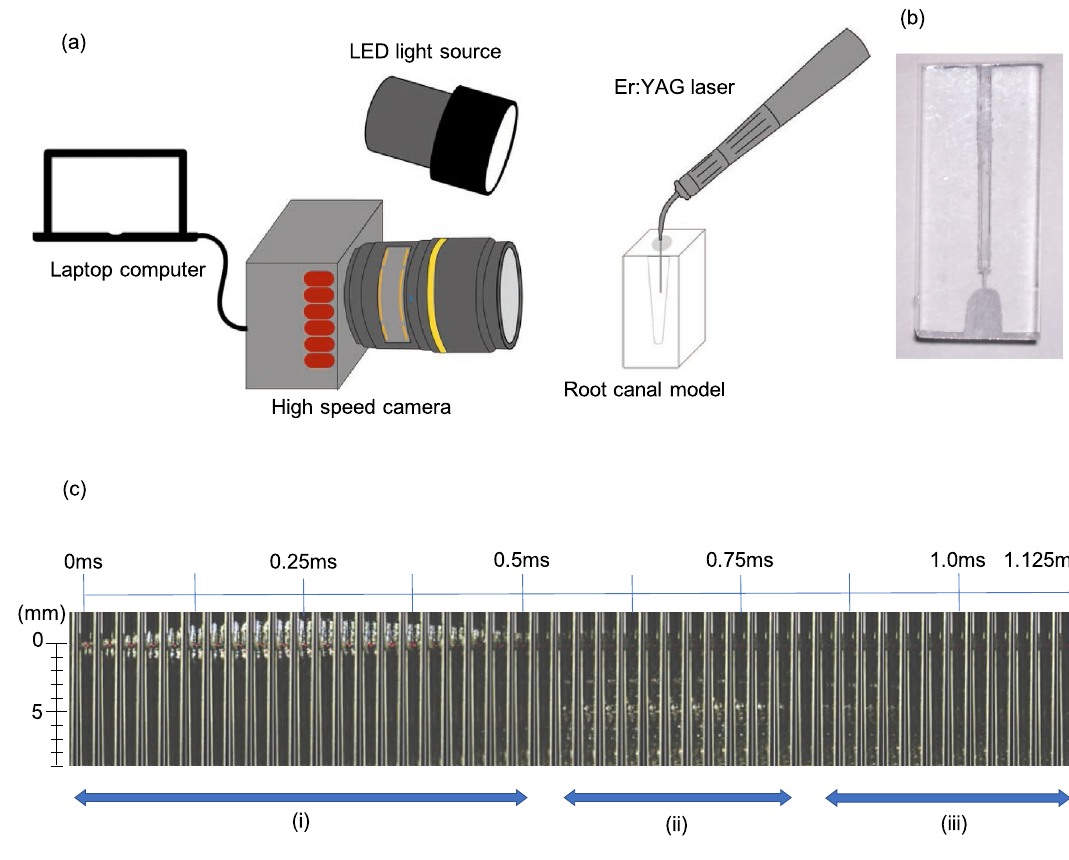
Figure 4. ( a ) Settings used for the observation of bubble behavior in a single pulse with a high-speed camera. ( b ) Single canal model. ( c ) Captured images showing the generation and disappearance of vapor bubbles at the tip, and the generation of cavitation bubbles. Recording conditions were set at 40,000 fps, 384 × 256 pixels, and 217 ms. At the tip, the bubbles generated at t = 0 ms notably developed in the crown direction, shrank, and finally disappeared at t = 0.525 ms (i). Additionally, several cavitation bubbles could be observed from t = 0.625 ms to t = 0.825 ms at the central part of the canal (ii). The cavitation bubble was observed to generate and disappear again within the same time range from 0.875 ms to 1.15 ms (iii).